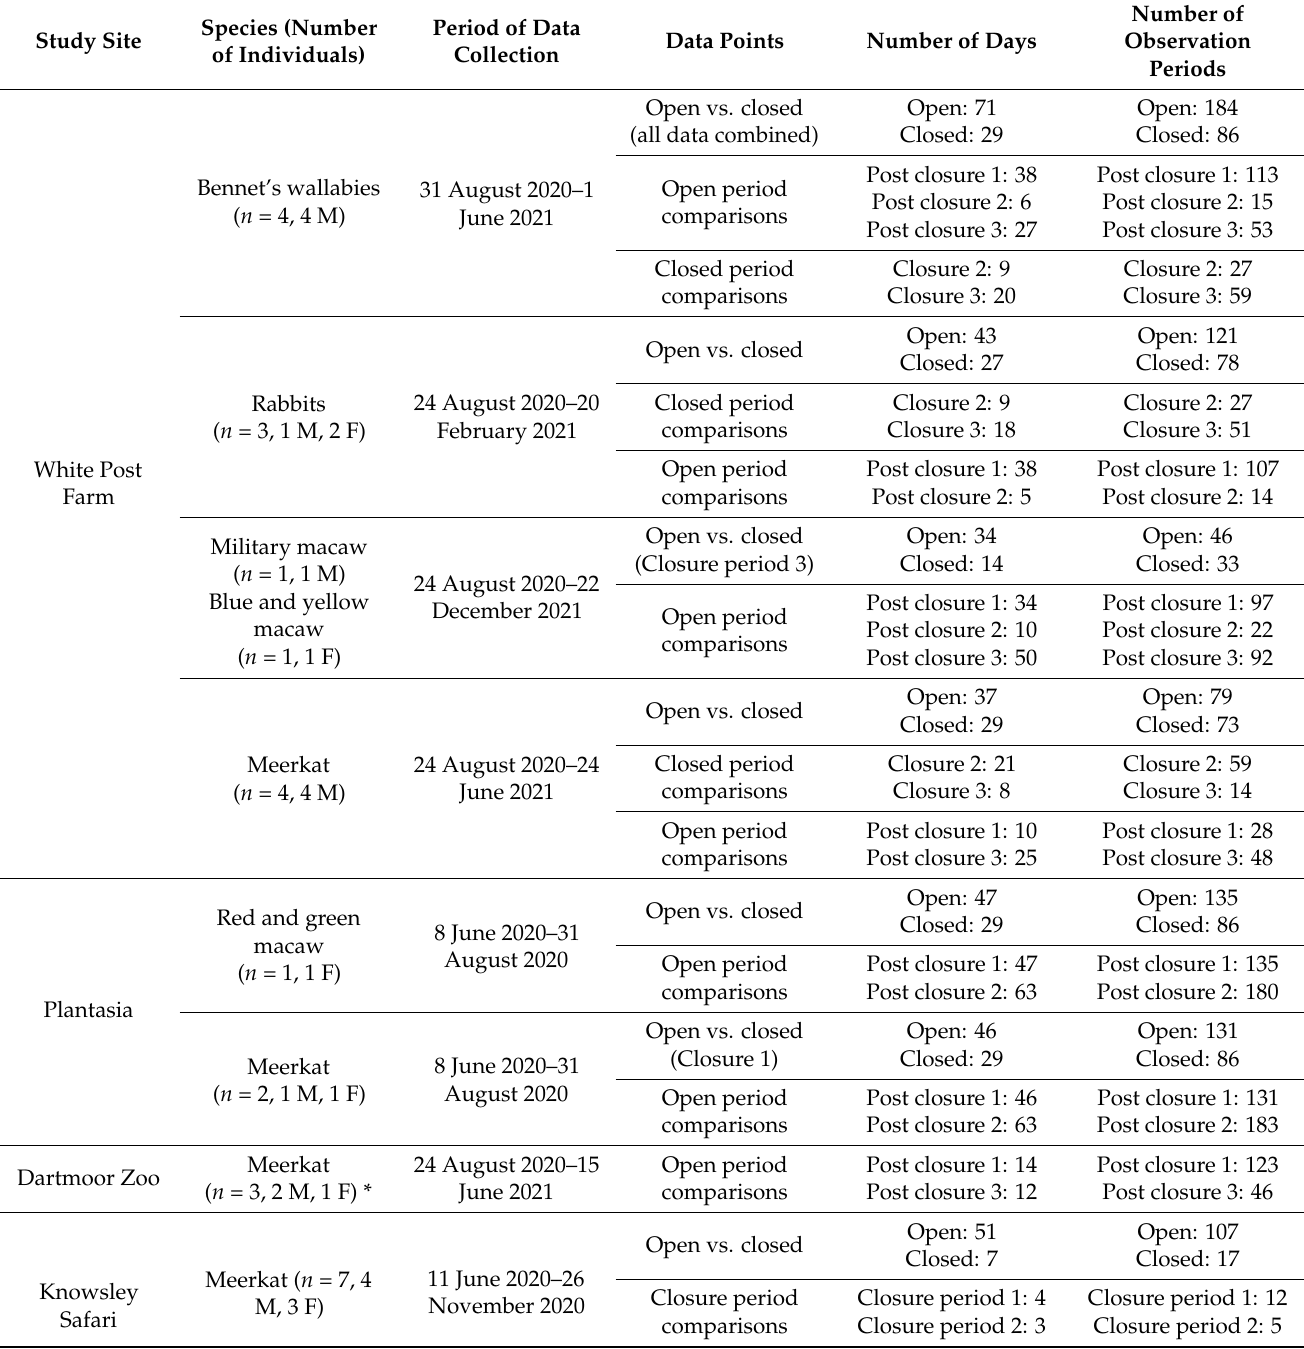
Table 1. An overview of study individuals and periods of data collection. Observation days reflect number of days animals were observed within the three closure and following reopening